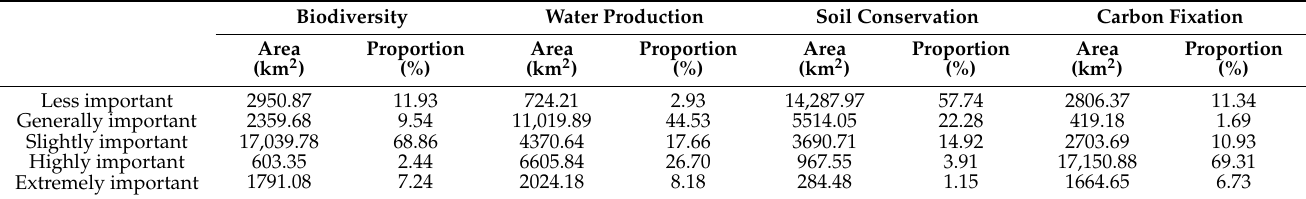
Table 2. Area and proportion of importance of each function of ecosystem